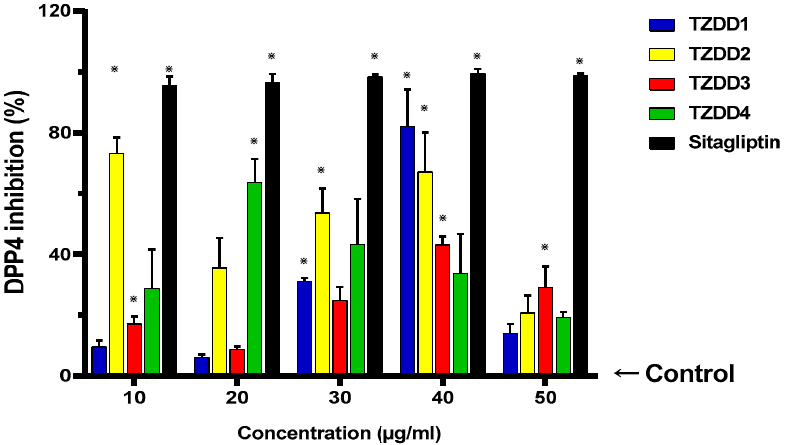
Figure 7. The inhibition of DPP-4 activity by TZD derivatives (10, 20, 30, 40, and 50 µg/mL). The results are represented in a clustered column. Data are presented as mean ± standard deviation values. The error bars correspond to the standard errors of the means, and asterisks (*) indicate a significant statistical difference relative to the control experiment ( p value ≤ 0.05). The arrow from the right pointing at the baseline at 0.0 represents the negative control, which is defined to have zero percent inhibition for the purpose of data normalization.